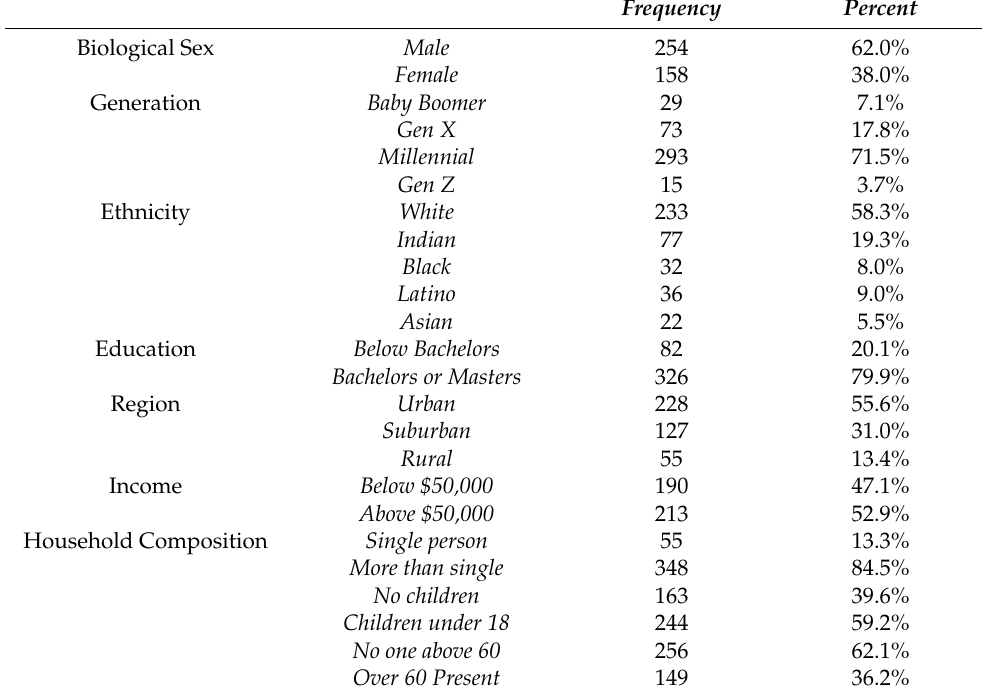
Table 1. Demographics for Sample.